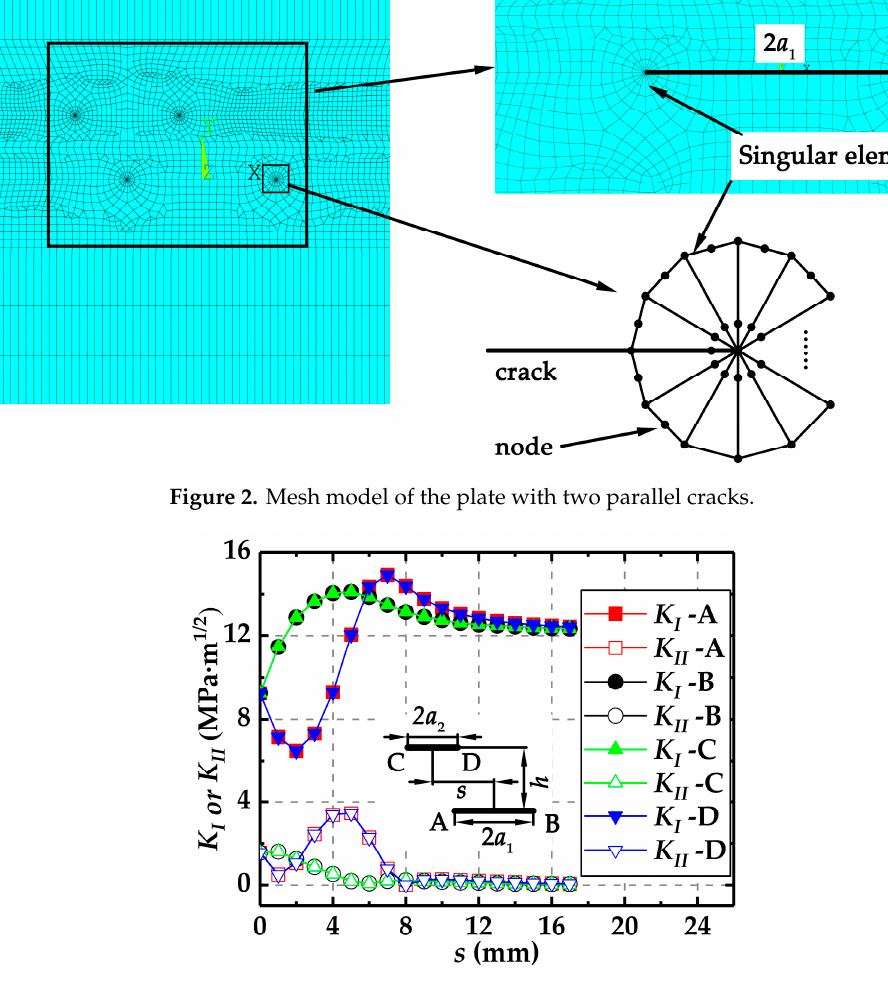
Figure 2. Mesh model of the plate with two parallel cracks.